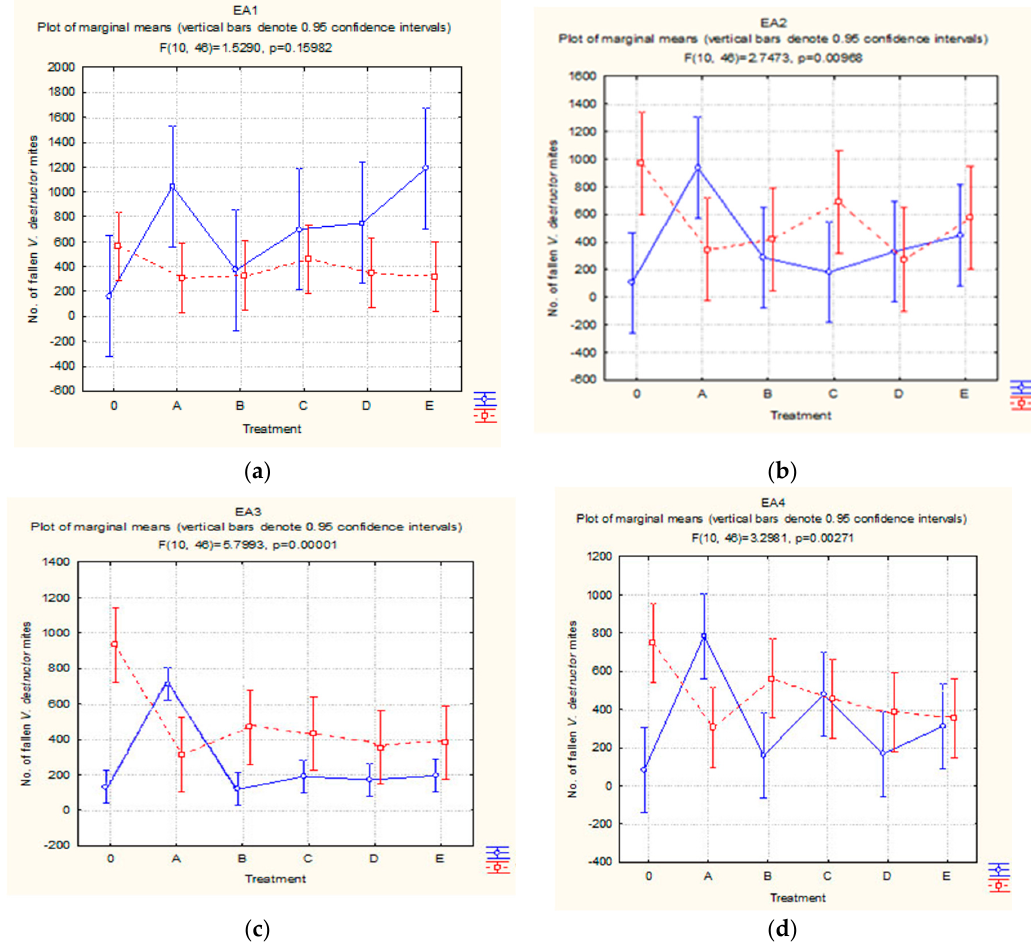
Figure 4. Differences in the number of fallen Varroa destructor mites between experimental groups (A, B, C, D, E) and control groups (O), during summer (blue lines) and winter treatment (red lines); mean ± SD. ( a ) EA1, ( b ) EA2, ( c ) EA3, ( d ) EA4. Diversity 2019 , 11 , x